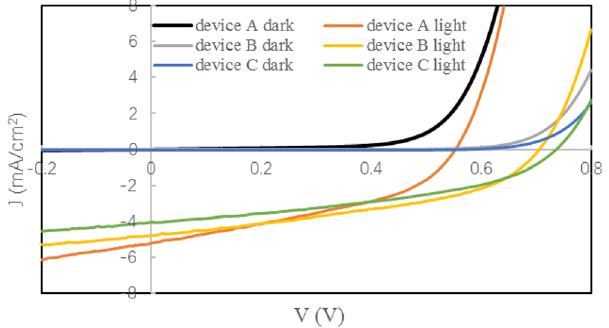
Figure 2. Current density-voltage (J-V) curves of standard device A modified device B and device C in the dark and under light